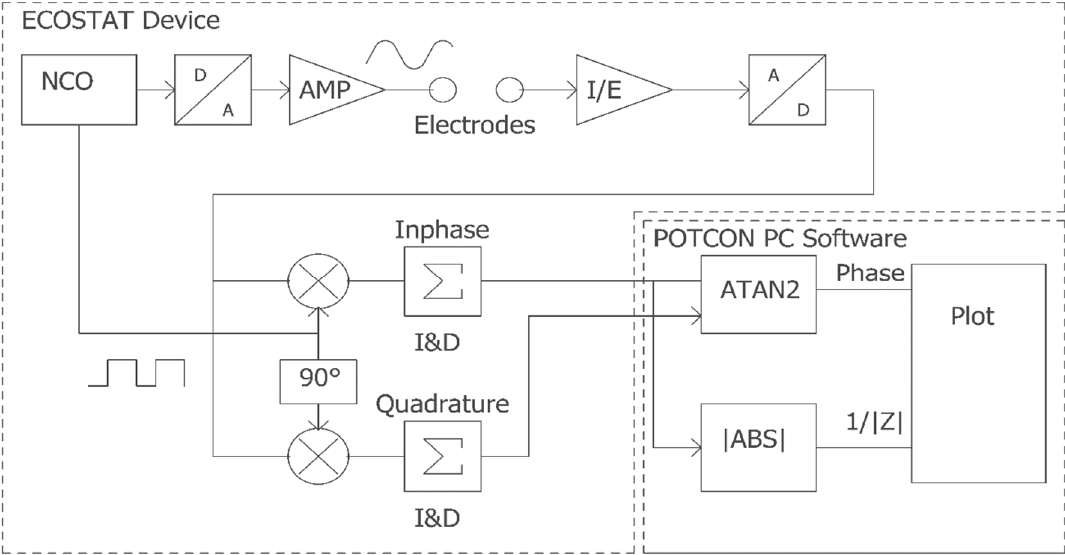
Figure 2. Detailed block diagram of the implemented EIS